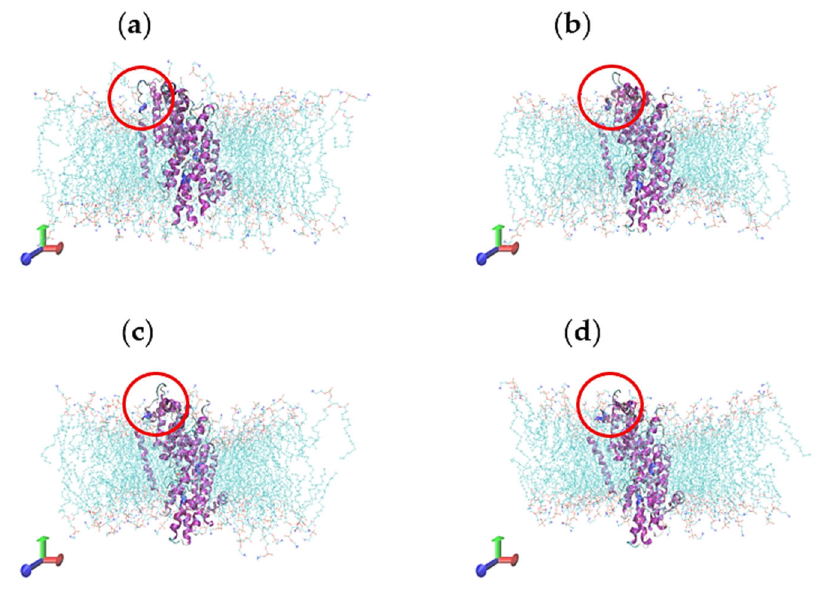
Figure 11. The binding conformations and molecular interaction of SoDIT-a-MAL system versus MD simulation course. ( a ) 0 ns, ( b ) 10 ns, ( c ) 20 ns, ( d ) 30 ns, SoDIT-a was in cartoon, membrane in line, a ligand in a circle.